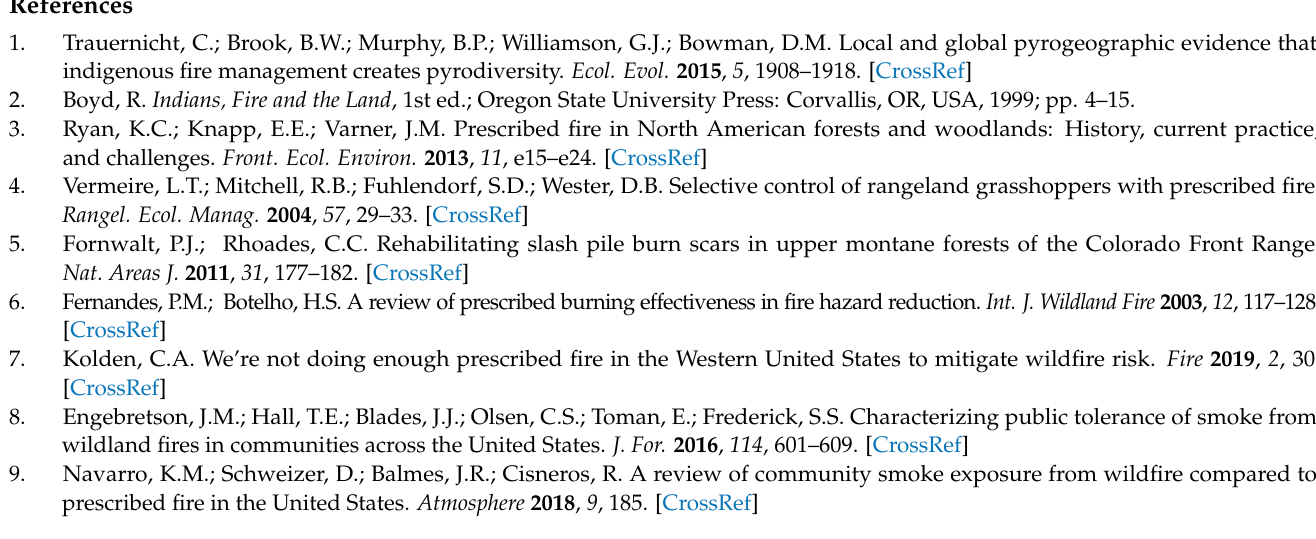
Figure S2: Cumulative distribution of ratio of actual and proposed prescribed fire parameters, Figure S3: Seasonal and interannual trends in ratio of actual and proposed prescribed fire parameters, Table S1: Interannual regression data transformations and percent change in R 2